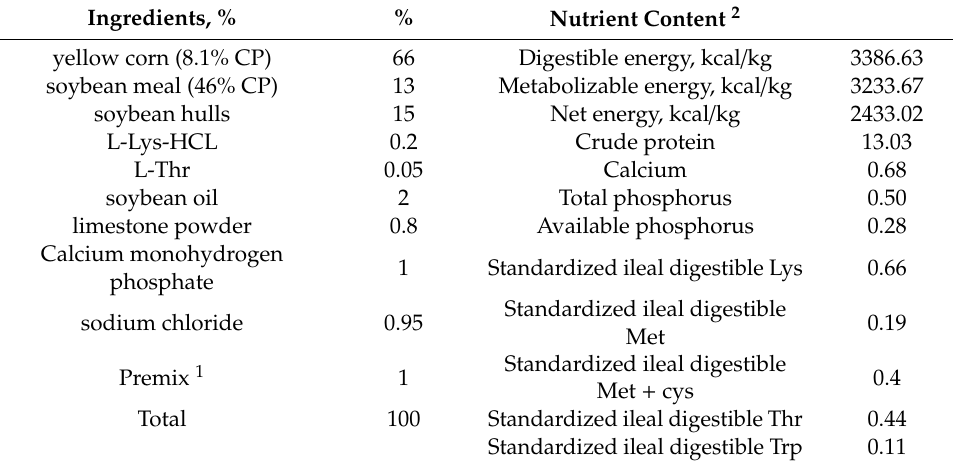
Table 1. Composition of the basal